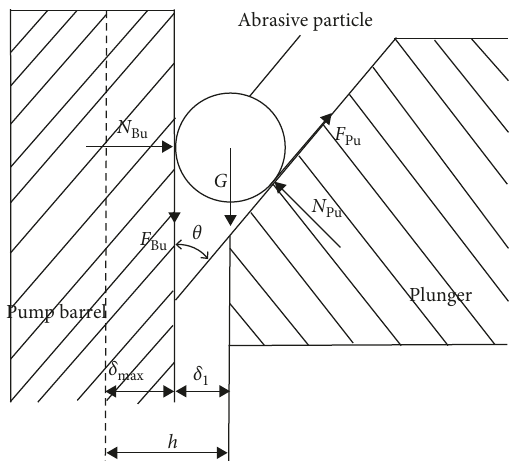
Figure 1: The forces of the abrasive particle on upstroke.